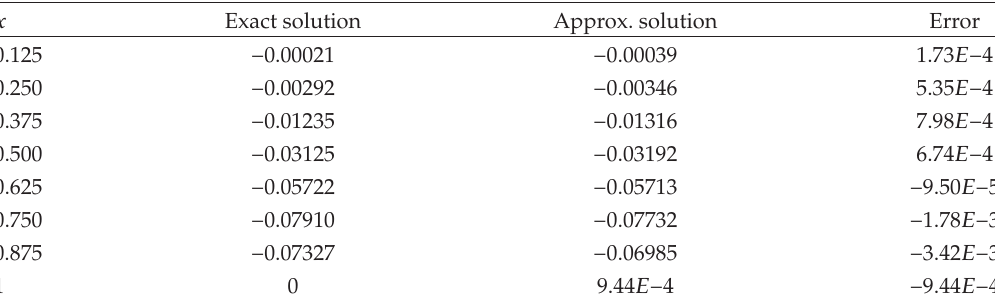
Table 4: Numerical results of Example